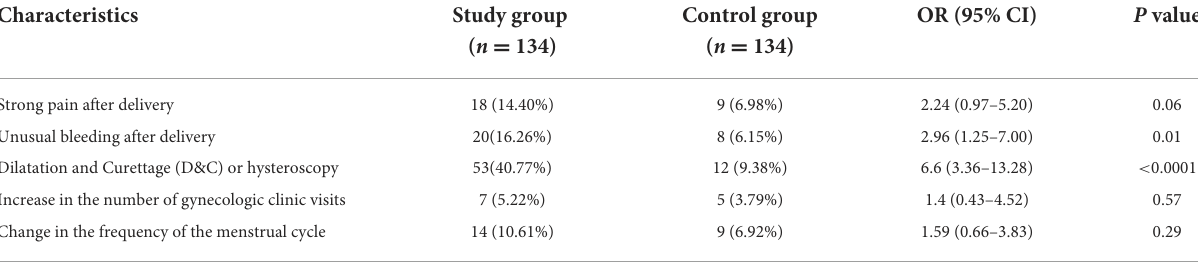
TABLE 1 Questionnaire responses following the index delivery for women following conservative treatment for placenta accreta spectrum vs. age-parity matched controls. Characteristics